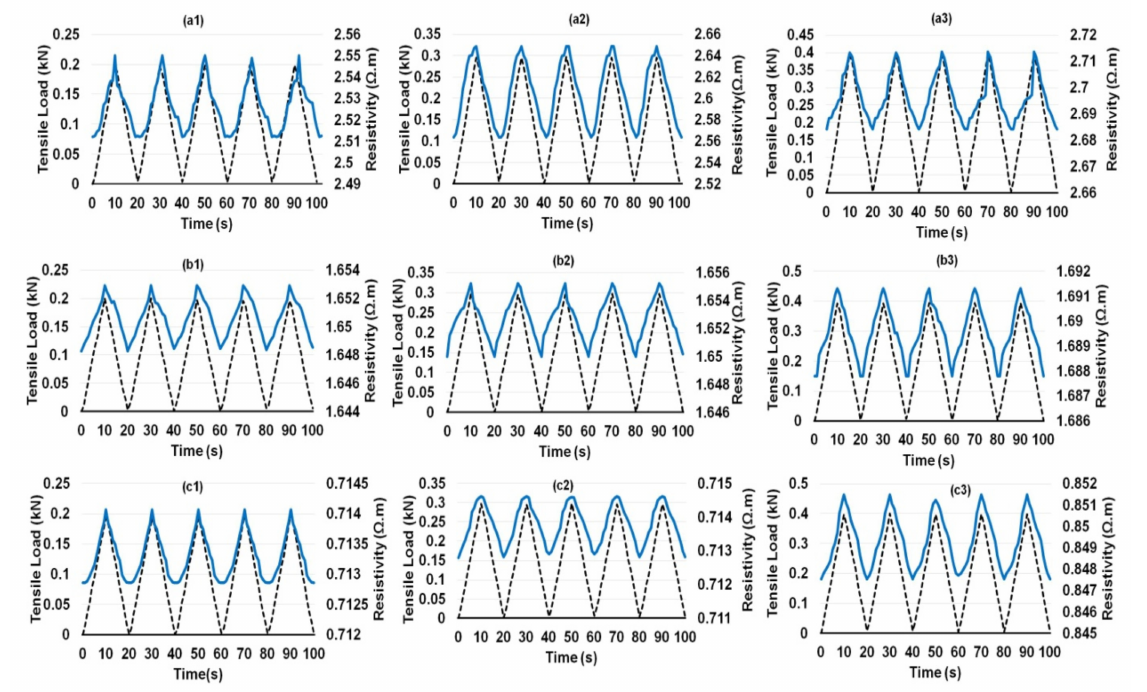
Figure 13. Change of electrical resistance with cyclic tensile load of 0.15% MWCNT-reinforced cementitious composites at different peak loads containing 0.25% CF ( a1 – a3 ), 0.50%SCF ( b1 – b3 ) and 0.75% SCF ( c1 – c3 ).